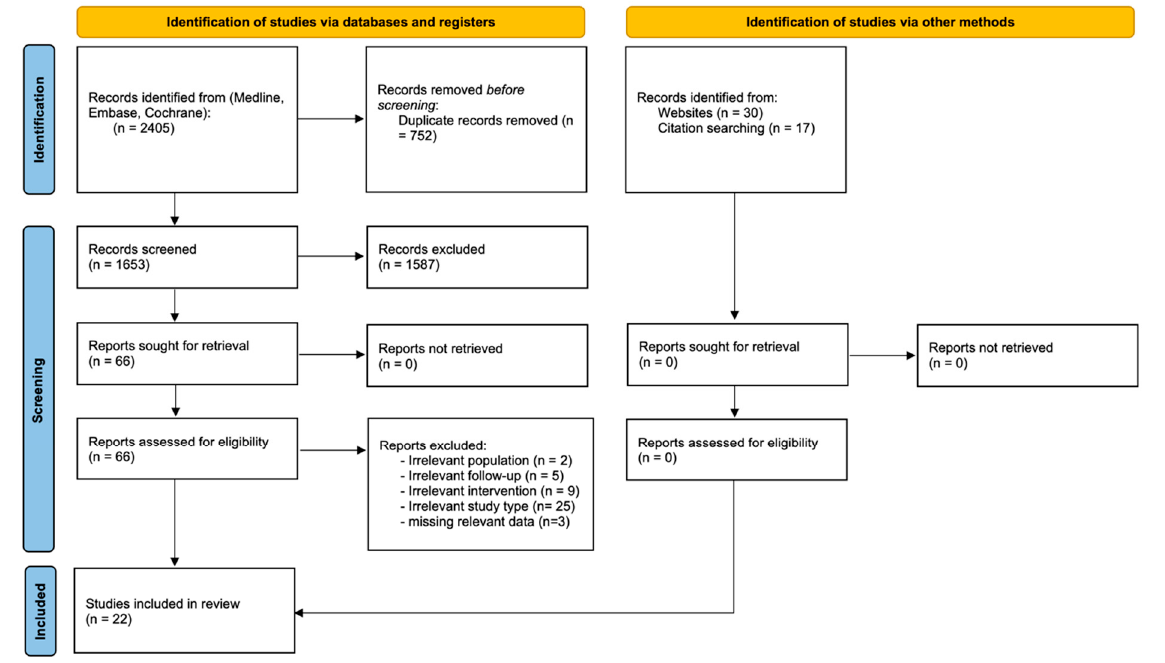
Figure 1. PRISMA 2020 flow diagram for new systematic reviews which included searches of data ‐ bases and other sources.